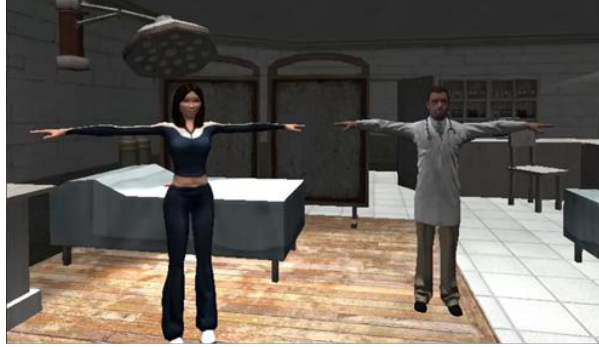
Figure 13. Avateering aimed to repeat movements